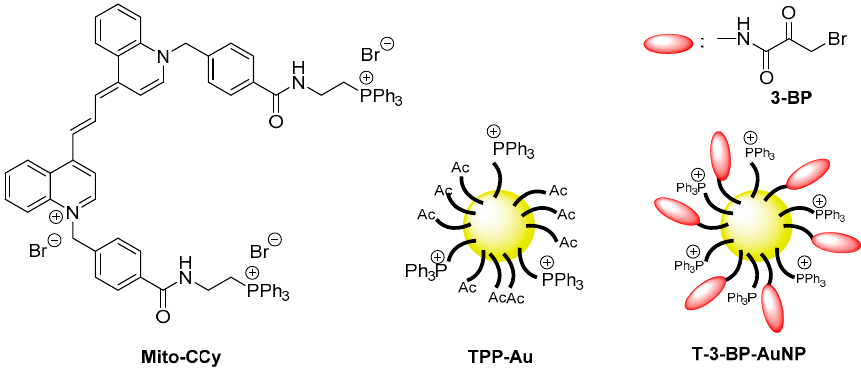
Figure 4. Mitochondria-targeting PTT reagents. Mito-CCy is a molecular based PTT reagent. TPP-Au is a gold nanoparticle-based PTT reagent, and T-3-BP-AuNP is combined with chemotherapy reagent